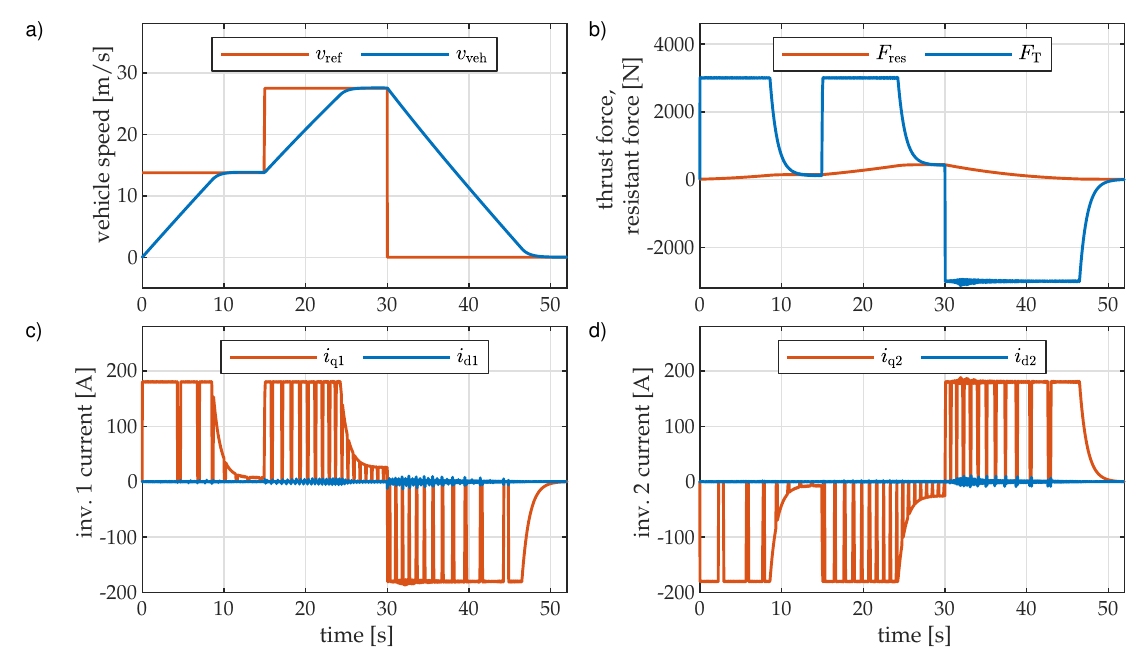
Figure 13. Example operation of the transportation system—simulation results. ( a ) commanded and vehicle speed, ( b ) thrust and resistant force, ( c ) inverter 1 output current components in the dq frame, ( d ) inverter 2 output current components in the dq frame.